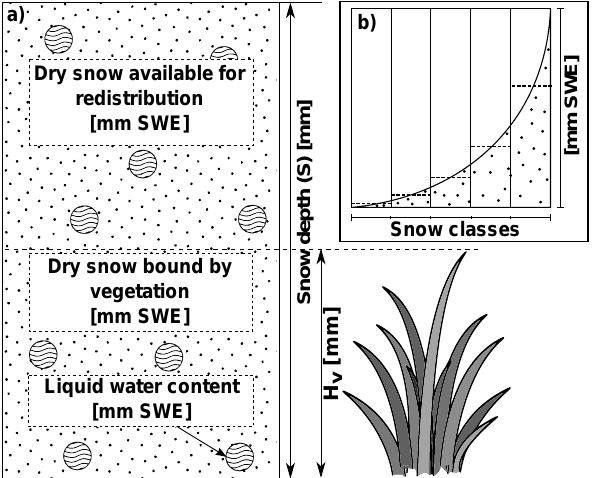
Figure 2. Schematic view of the snow cover in COSERO. (a) Com- position of one snow class. Vegetation or surface roughness defines the threshold value ( H v ) to hold back an amount of snow. (b) View of one grid cell including five snow classes each of which is com- posed in the way shown in (a) . Snowfall is distributed log-normally throughout the classes (dashed lines in b ). Note that snow depth S is given in millimetres while all other parameters regarding snow are given in millimetres of